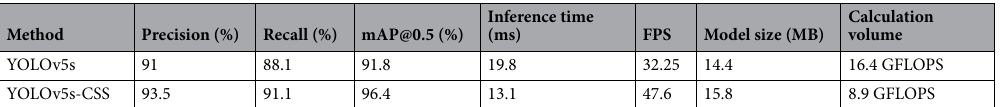
Table 11. Network performance test results of the proposed YOLOv5s-CSS network model and the original network model.